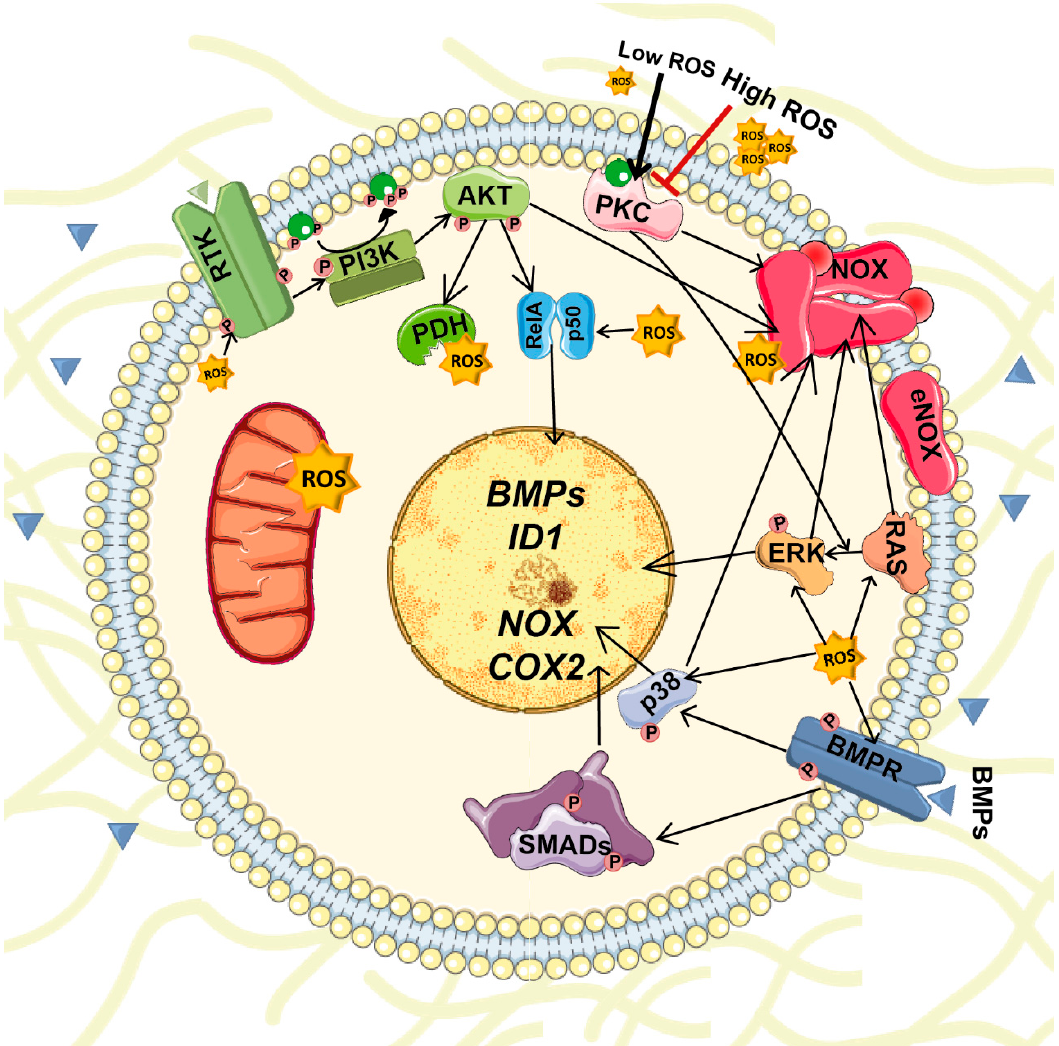
Figure 3. Interplay between BMPs and ROS signaling. Production of BMPs and ROSs are reciprocally regulated. BMPs stimulate ROS production by activation and/or induction of NOX1-5 expression while ROS regulate the expression of several BMPs. Furthermore, both BMPs and ROS activate several common signaling pathways including PI3K-AKT, ERK, JNK and p38 MAPKs.